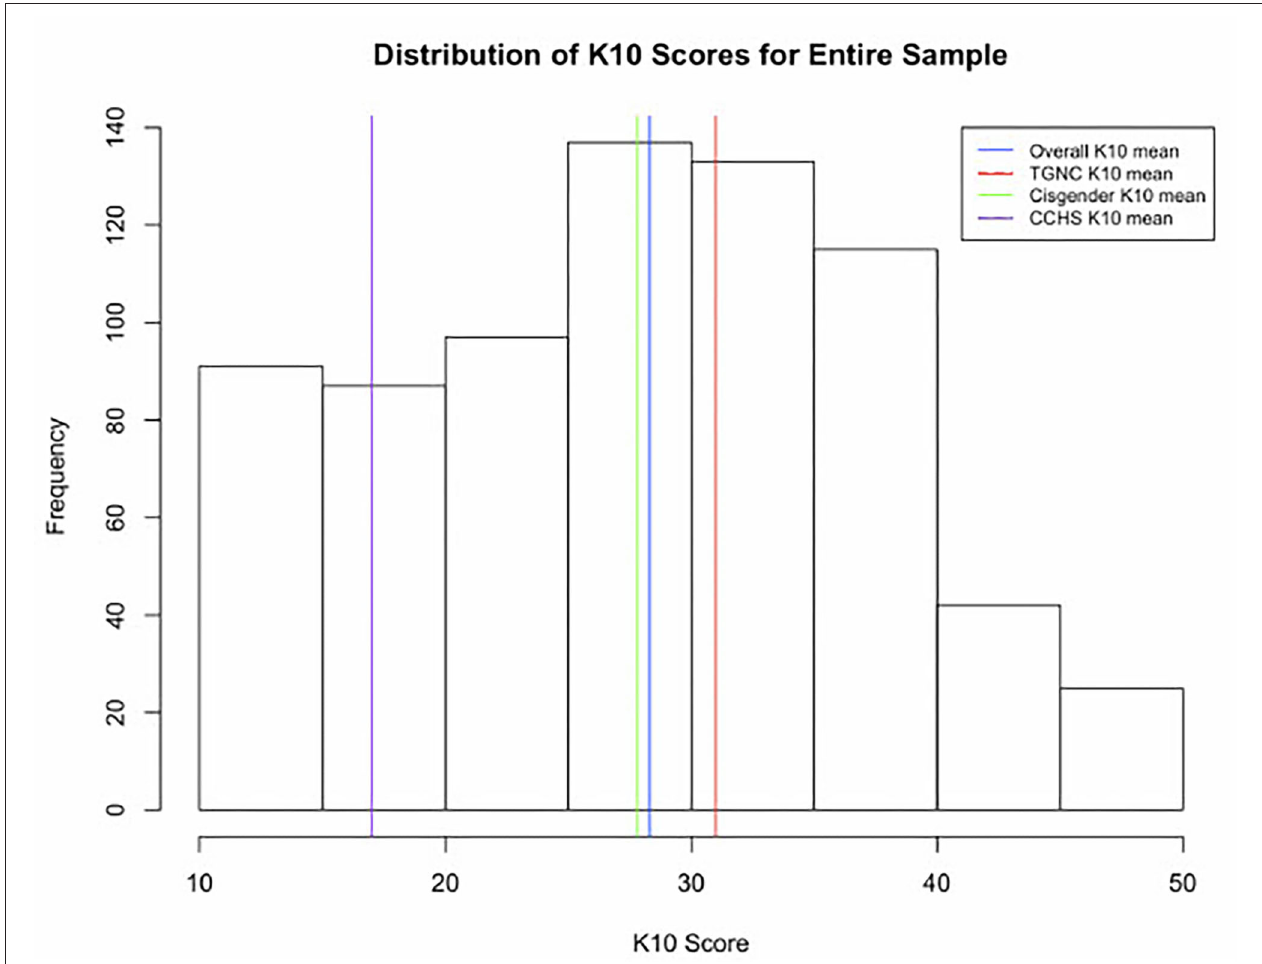
FIGURE 1 | Distribution of K10 scores in the sample ( n = 727). *The K10, or Kessler Psychological Distress Scale, is a standardized scale measuring psychological or mental health distress that was developed by Kessler (2002 and 2003). **For reference, K10 scores 10–15 “none to low physiological distress,” 16–21 “moderate psychological distress,” 21–29 “high psychological distress” and > 30 “very high psychological distress.” ***CCHS, 2012 Canadian Community Health Survey-Mental Health data; ***TGNC, transgender and/or gender